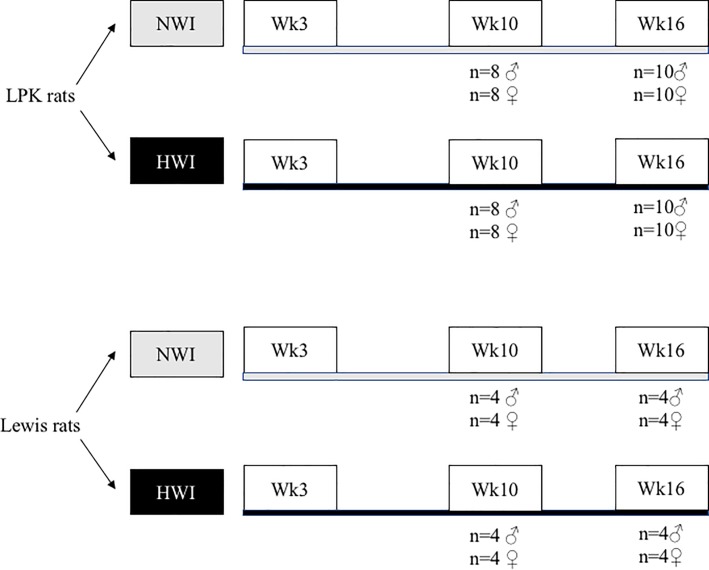
Experimental design.Female and male Lewis and LPK litter-mates were equally divided into two groups—HWI (tap water supplemented with 5% glucose) or NWI (normal water intake). The rats were sacrificed at either week 10 (LPK n = 33, Lewis n = 15) or week 16 (LPK n = 33, Lewis n = 17).